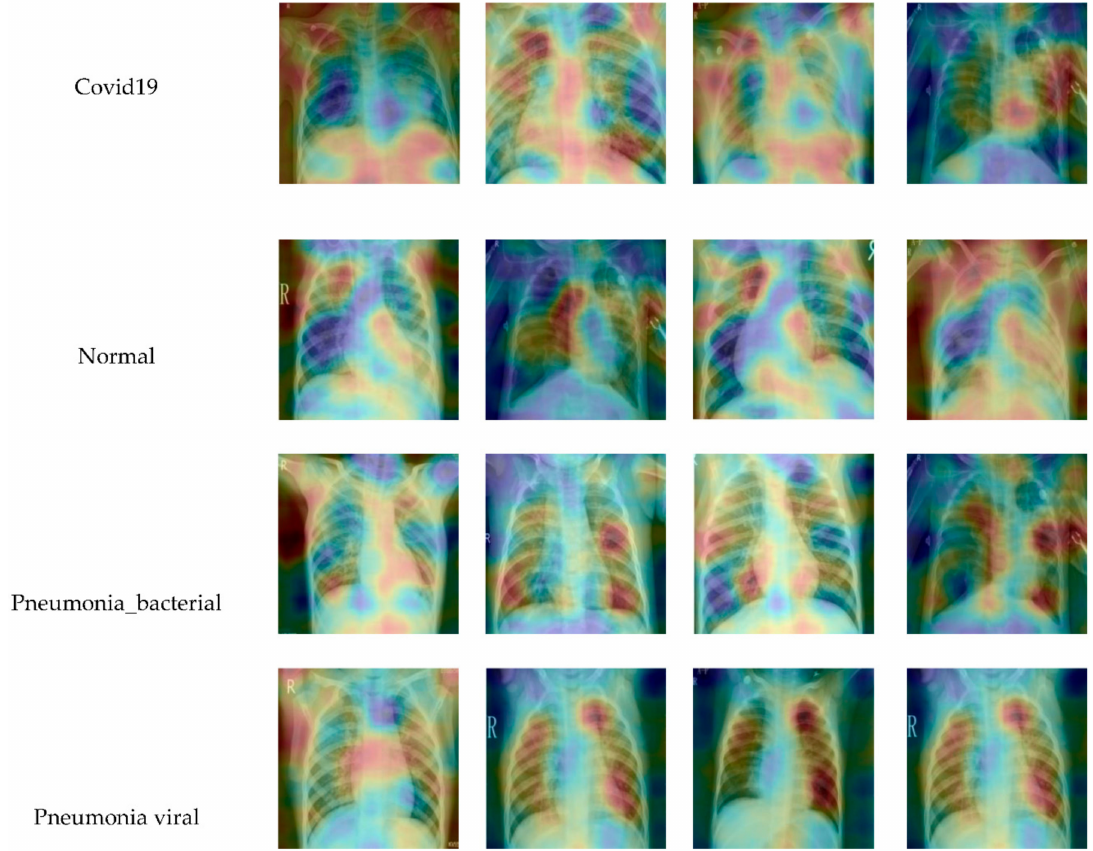
Figure 11. The visualization of some predicted samples based on our proposed model, using the RISE